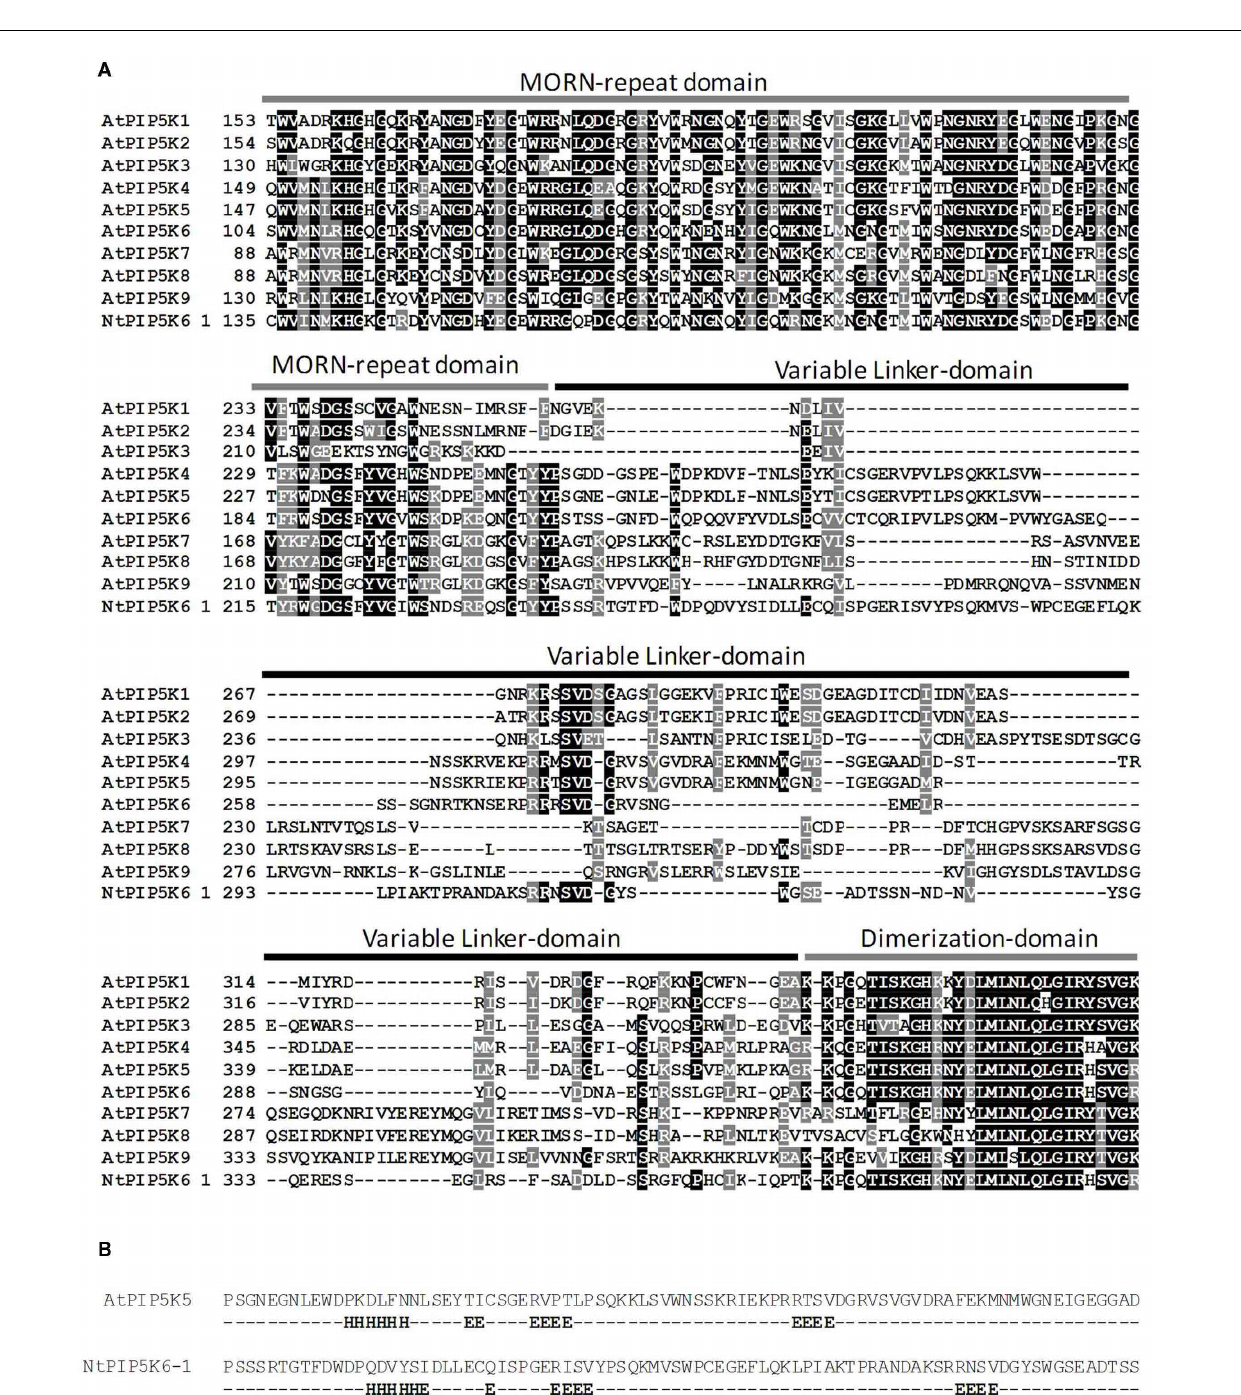
alignment of relevant parts of plant PI4P 5-kinases of subfamily B. Black, identical amino acids; gray, similar amino acids.The positions of MORN domain, Lin domain and Dim domain are indicated. (B) , Secondary structure prediction for the Lin domains of AtPIP5K5, NtPIP5K6-1, and AtPIP5K2. H, α -helix; E, β